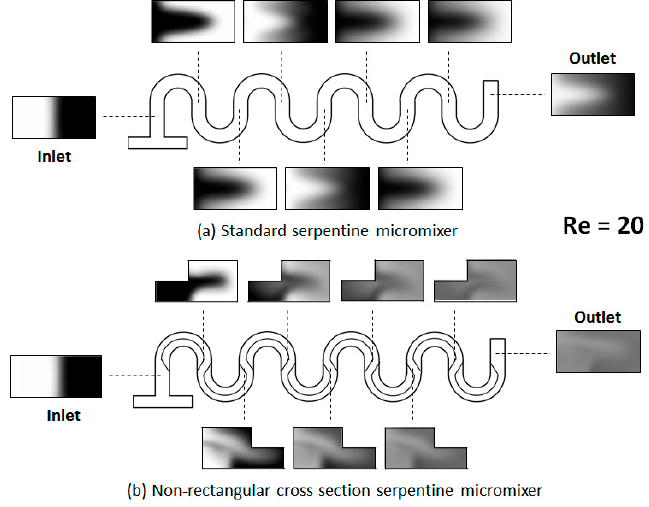
Figure 5. Transversal concentration distribution at various positions along the channel for ( a ) a standard serpentine micromixer and ( b ) a serpentine micromixer with a non-rectangular cross-section ( Re = 20). The concentration is mapped at both the midpoint and the end of each mixing unit.